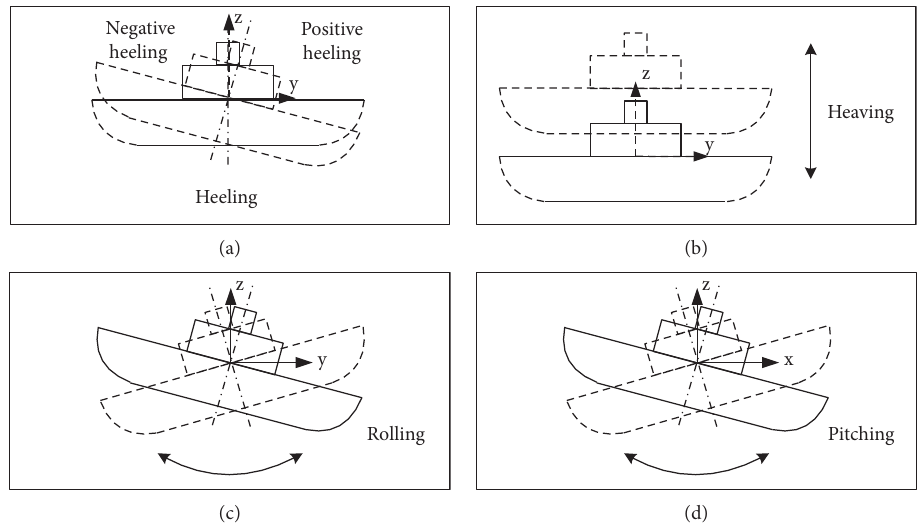
Figure 2: Schematic of ocean motions. (a) Heeling. (b) Heaving. (c) Rolling. (d)